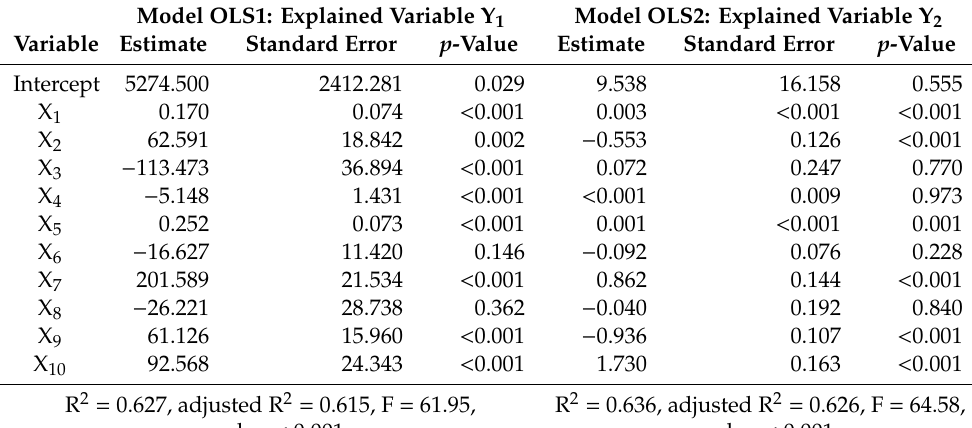
Table 3. Parameters of OLS (ordinary least squares) models with response variables Y 1 and Y 2 . Model OLS1: Explained Variable Y 1 Model OLS2: Explained Variable Y